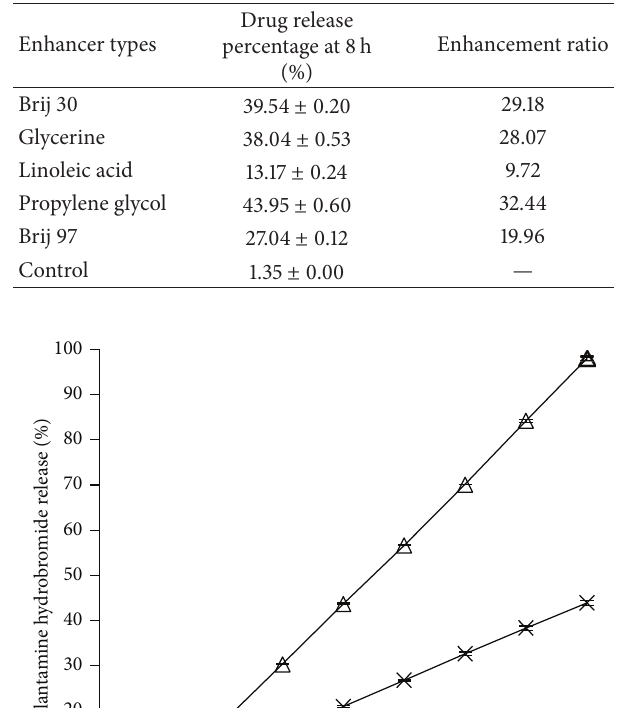
Table 2: Percentage of drug release at 8h from different gel formulations (mean ± S.D.; 𝑛 = 3 ).